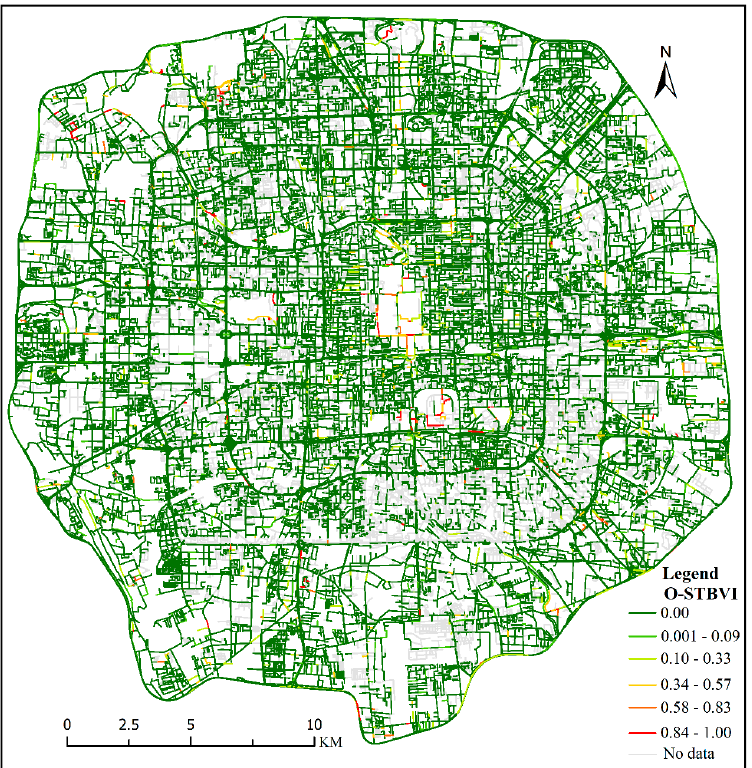
Figure 10. Spatial distribution of the STBVI of the official-style buildings.